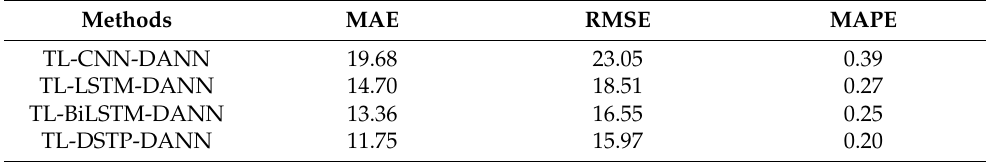
Table 3. Accuracy comparison of different feature extractors combined with DANN for PM2.5 prediction. Methods MAE